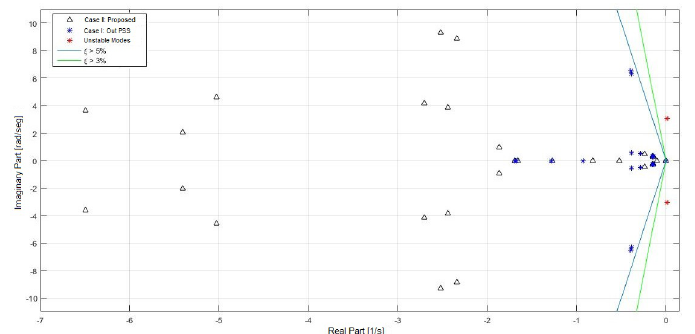
Figure 16. Eigenvalues system